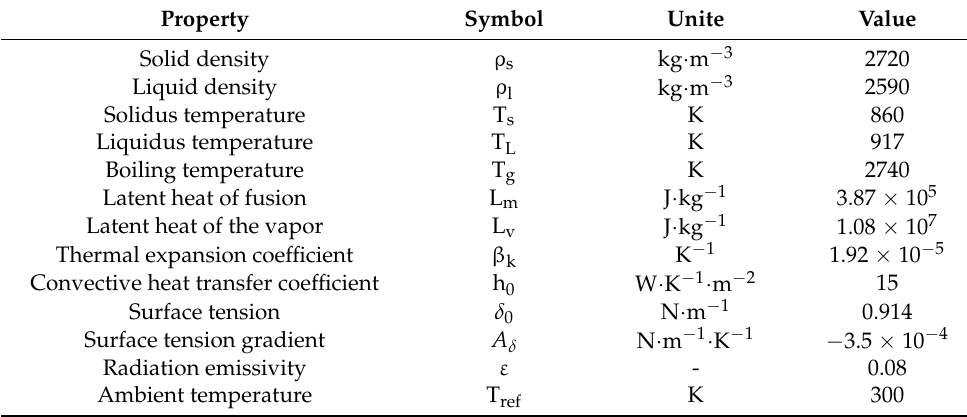
Table 1. Physical and thermal properties of 6056 aluminum alloy.